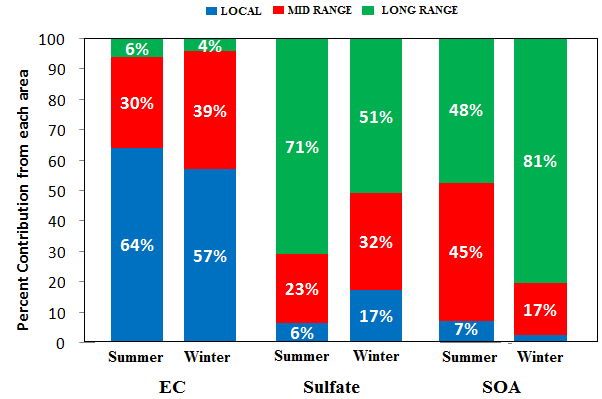
Fig. 9. Comparison of the contributions of each source area for the summer and winter